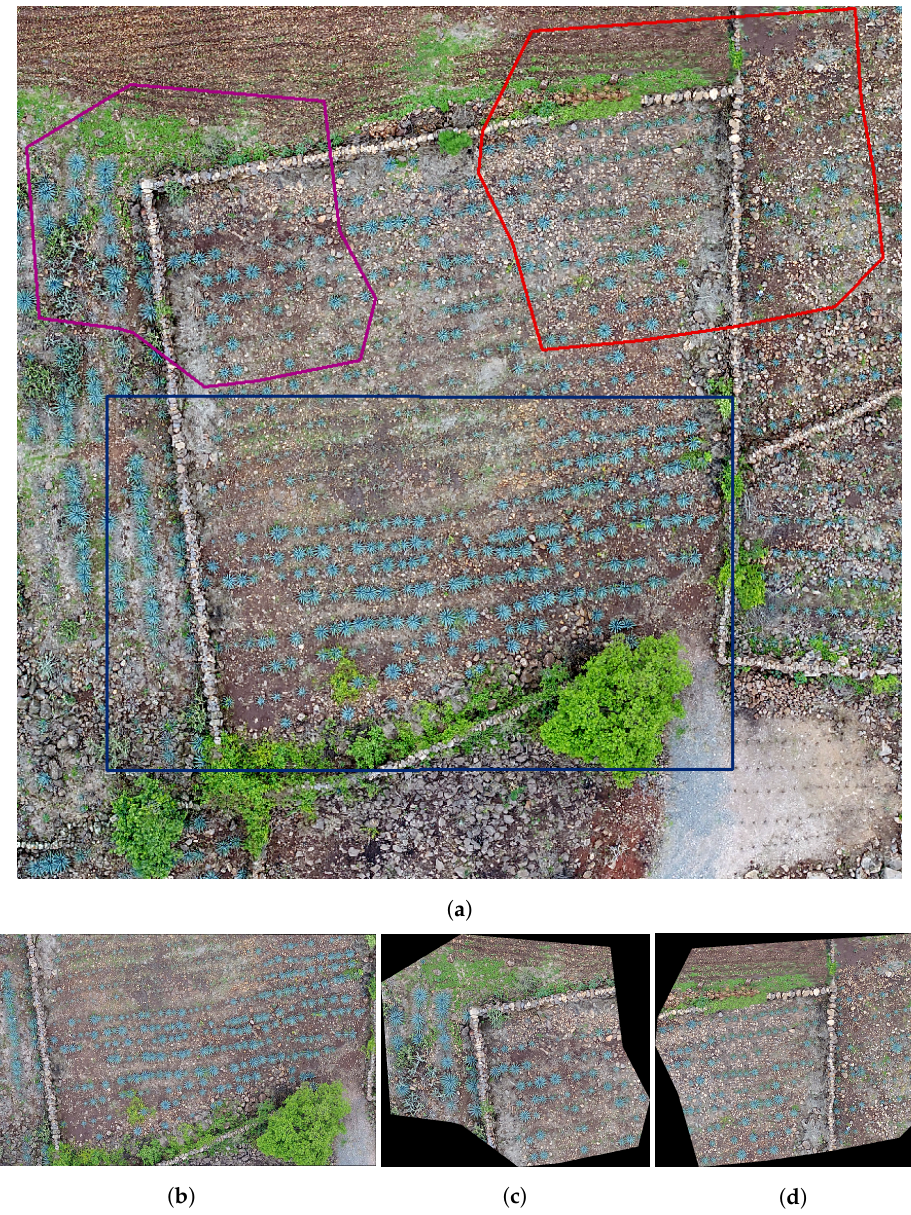
Figure 3. Images of Field 2 obtained with an UAV: ( a ) Field 2 with some marked regions that are studied in this work, ( b ) the region in blue, ( c ) the region in purple, and ( d ) the region in red. Field 3 is of the same red clay as in Field 1. The overlap problem and weeds are also present. Note that, in this case, the variability of plant sizes is lower than the variability in Fields 1 and 2. The sowing system of the blue agave is linear; see Figure 5. The lines can be made through a tractor, stakes, or manually with a thread. The furrows are distributed at a distance allowing for separation between the plant rows. Afterwards, a thread with marks is utilised to fix the needed distance between